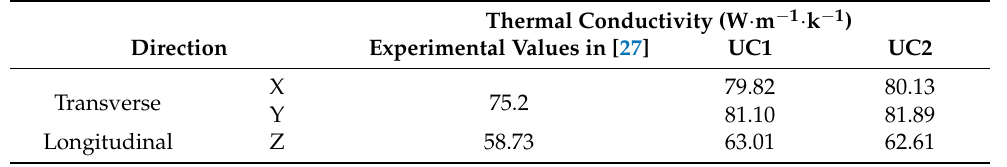
Table 4. Comparison of the FE results with the experimental results in